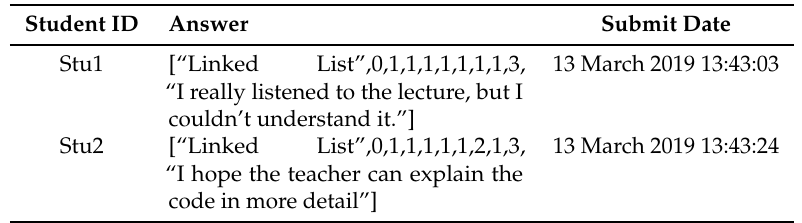
Table 1. Samples of translated students’ feedback.